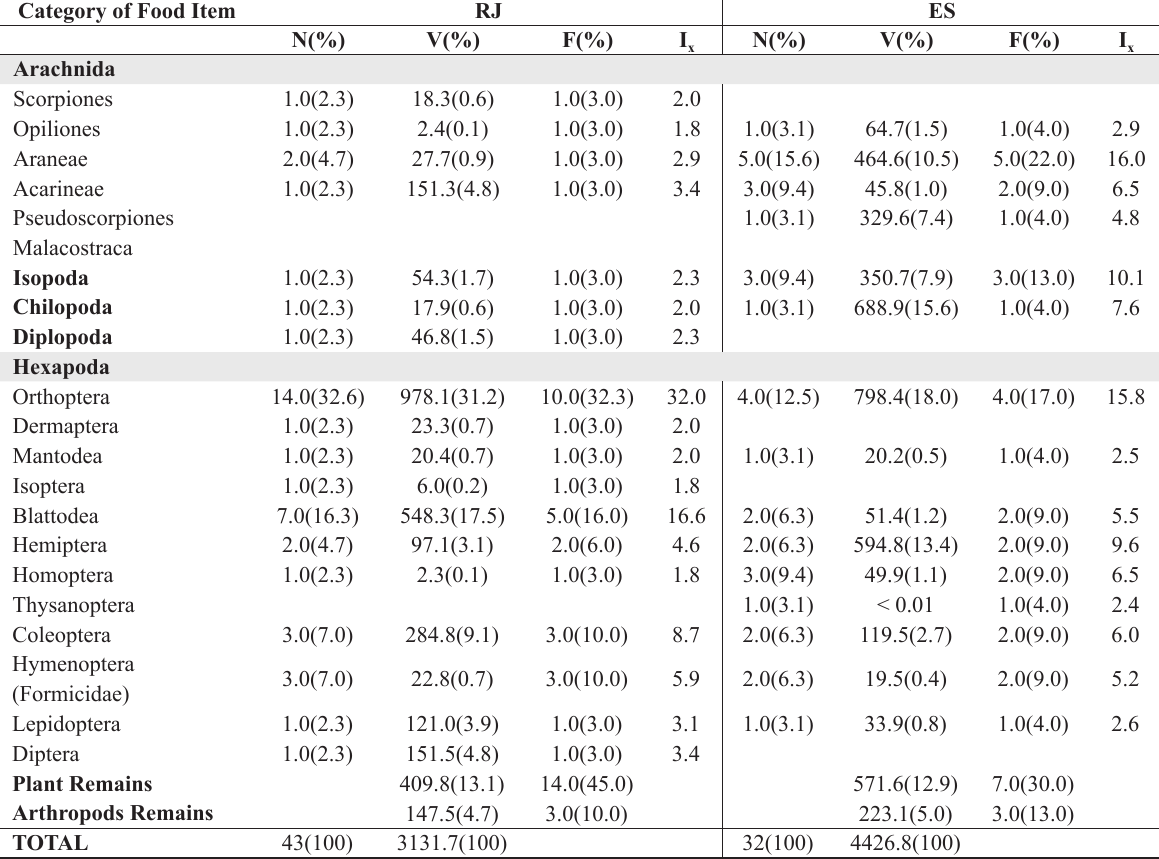
Number (N), volume (V, in mm 3 ), frequency of occurrence (F) and Index of Importance (I food item in the diet of the anuran Haddadus binotatus in Atlantic Rainforest of the states of Rio de